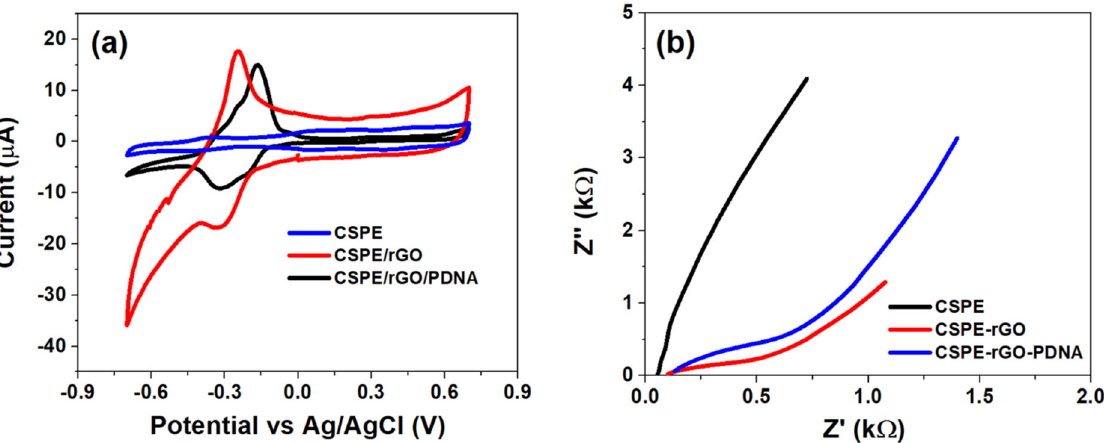
Figure 2. ( a ) CV plot within ‐ 0.7 to 0.7 V at 100 mV/s and ( b ) Nyquist plot recorded between 0.1 Hz ‐ 0.1 MHz (100 mV A.C) at different stages of sensor fabrication.